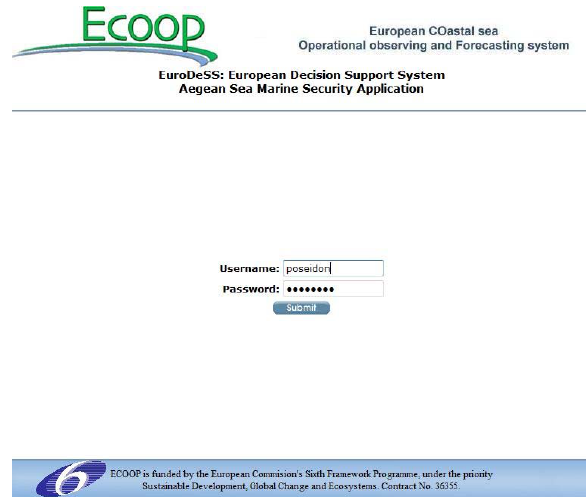
Figure 1: The first page of the Aegean DeSS (http://eurodess.hcmr.gr) where the user should provide the credential information in order to be able to use the system